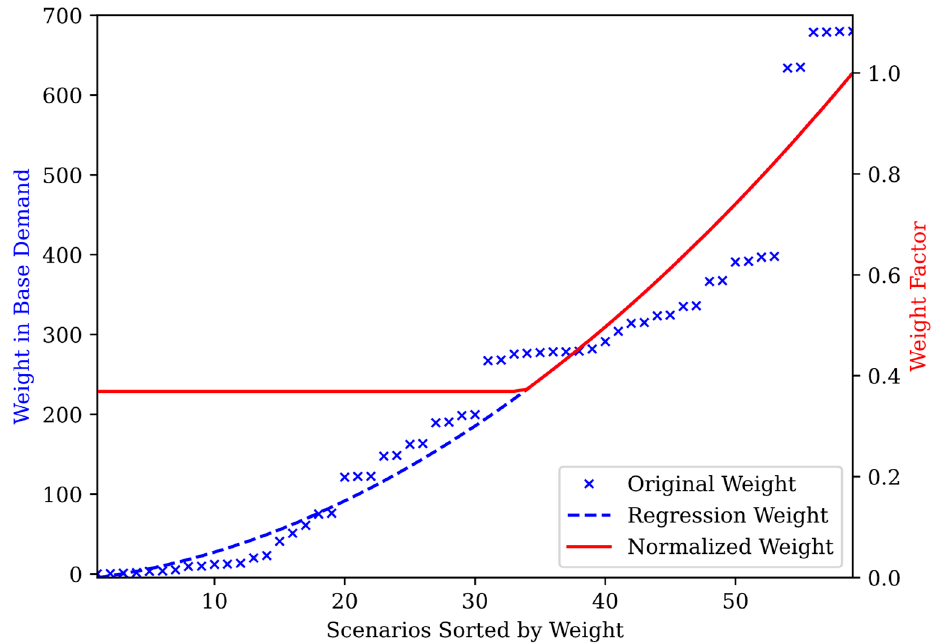
Figure 4. Example of scenario weight.